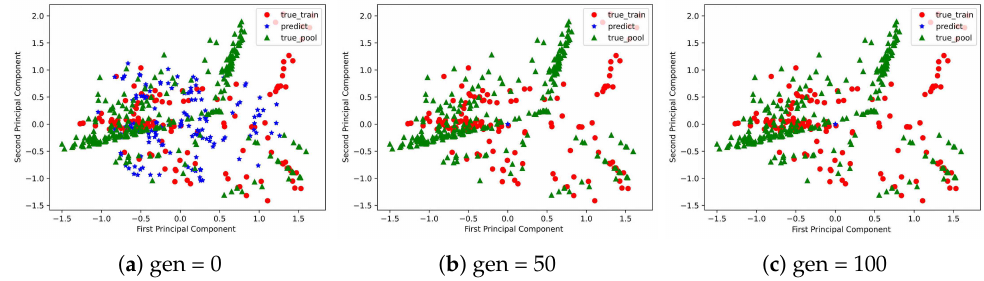
Figure 11. Population evolution of RBM-IGA based on the RBM surrogate model.